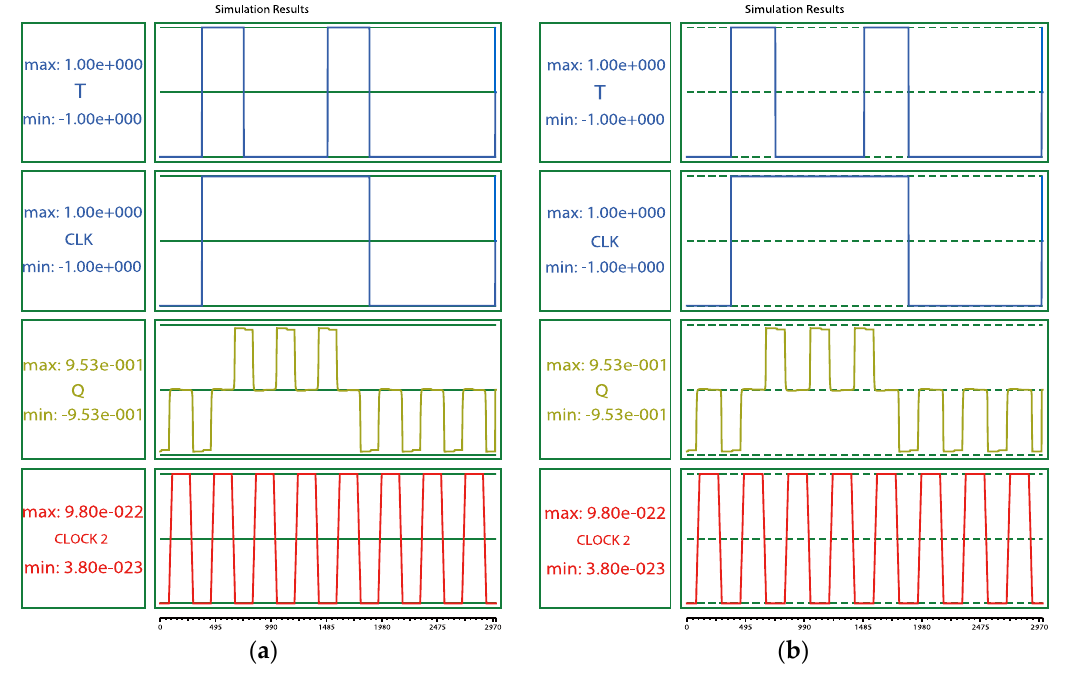
Figure 9. Simulation results of the proposed LST-FF circuits. ( a ) The first LST-FF (LST-FF1) and ( b ) the second LST-FF (LST-FF2).